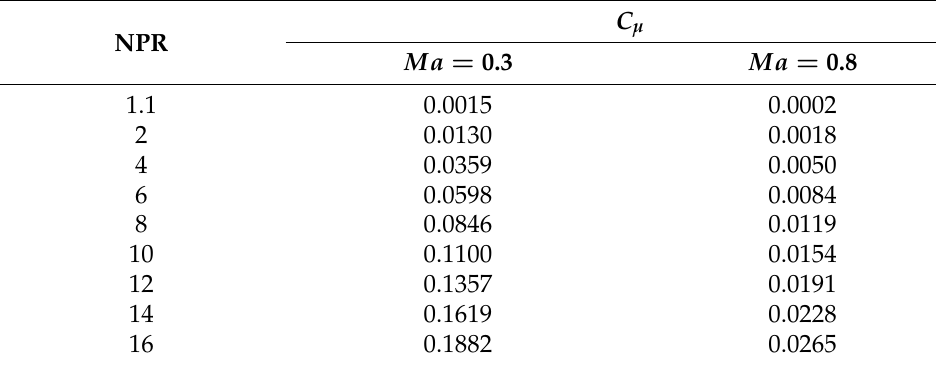
Table 1. Correspondence between NPR and C µ